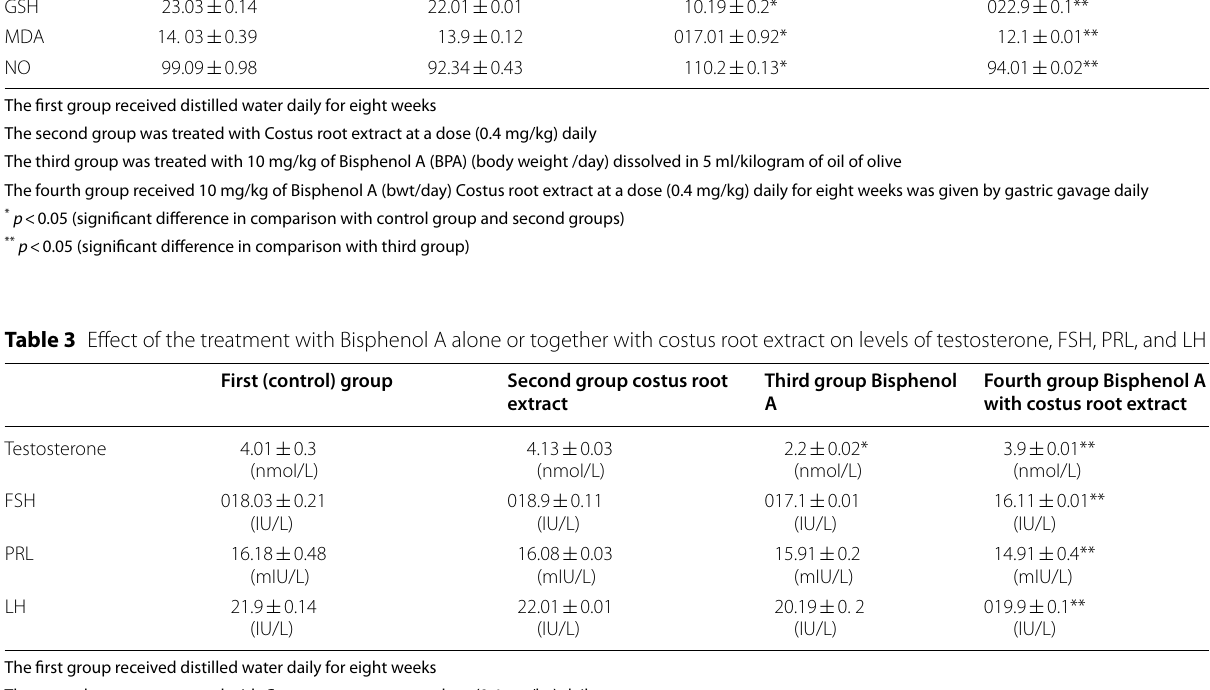
The first group received distilled water daily for eight weeks The second group was treated with Costus root extract at a dose (0.4 mg/kg) daily The third group was treated with 10 mg/kg of Bisphenol A (BPA) (body weight /day) dissolved in 5 ml/kilogram of oil of olive The fourth group received 10 mg/kg of Bisphenol A (bwt/day) Costus root extract at a dose (0.4 mg/kg) daily for eight weeks was given by gastric gavage daily * p < 0.05 (significant difference in comparison with control group and second groups)